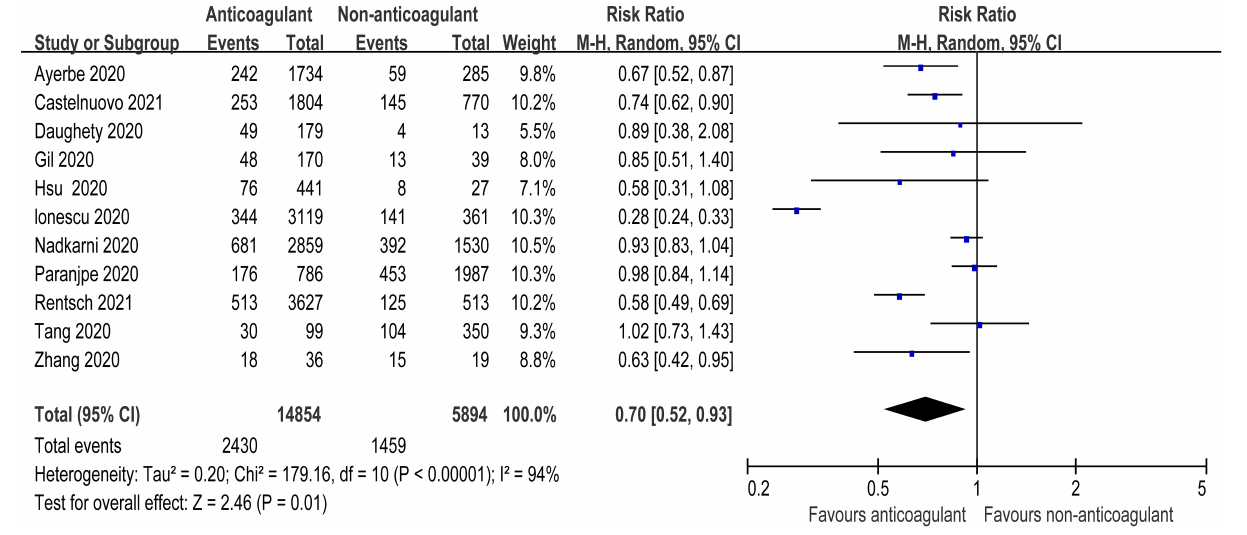
from 29.8 to 40% vs. 62.7 to 78.9% in severe to critical COVID-19 patients, respectively (9–11, 23–30). Of